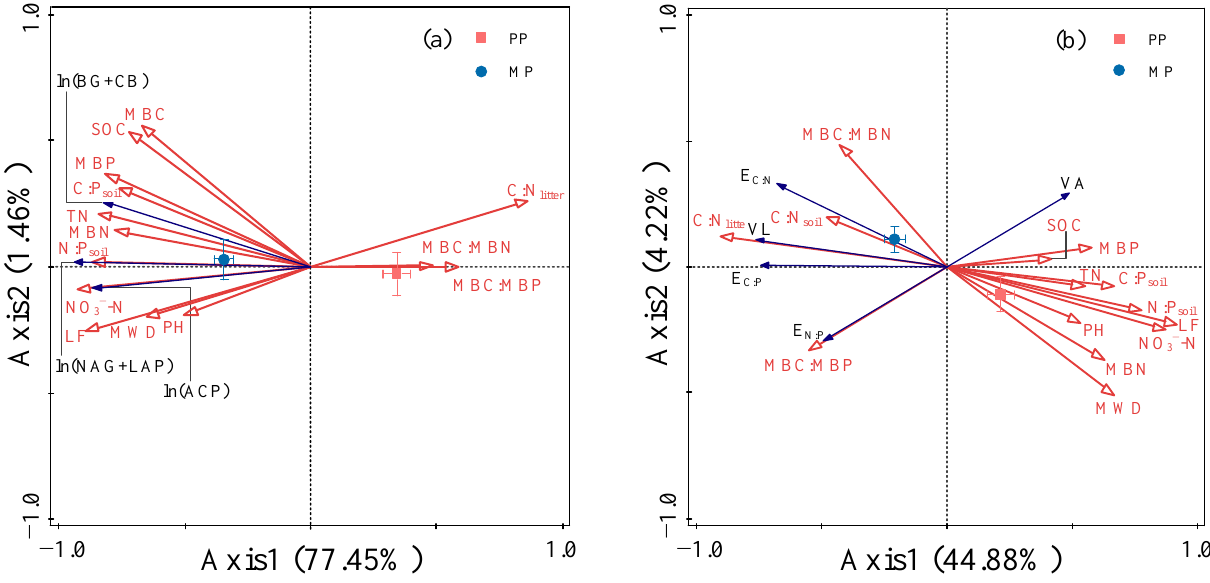
Figure 6. Results of a redundancy analysis (RDA) that was used to identify the relationship between extracellular enzymatic activity (EEA) and environmental variables ( a ), and between extracellular enzymatic stoichiometry (EES) and environmental variables ( b ). LF, litterfall; C:N litter , litter carbon to nitrogen ratio; SOC, soil organic carbon; TN, total nitrogen; C:N soil , soil organic carbon to total nitrogen ratio; C:P soil , soil organic carbon to total phosphorus ratio; N:P soil , soil total nitrogen to total phosphorus ratio; NO 3 – -N, nitrate nitrogen; MWD, mean weight diameter; MBC, microbial biomass carbon; MBN, microbial biomass nitrogen; MBP, microbial biomass phosphorus; MBC:MBN, microbial biomass carbon to microbial biomass nitrogen ratio; MBC:MBP, microbial biomass carbon to microbial biomass phosphorus ratio. E C:N , ln(BG + CB):ln(NAG + LAP); E C:P , ln(BG + CB):ln(ACP); E N:P , ln(NAG + LAP):ln(ACP); VL, vector length; VA, vector angle. Table 4. Simple and conditional effects of environmental factors on soil extracellular enzymatic activity (EEA) identified in the redundancy analysis (RDA).